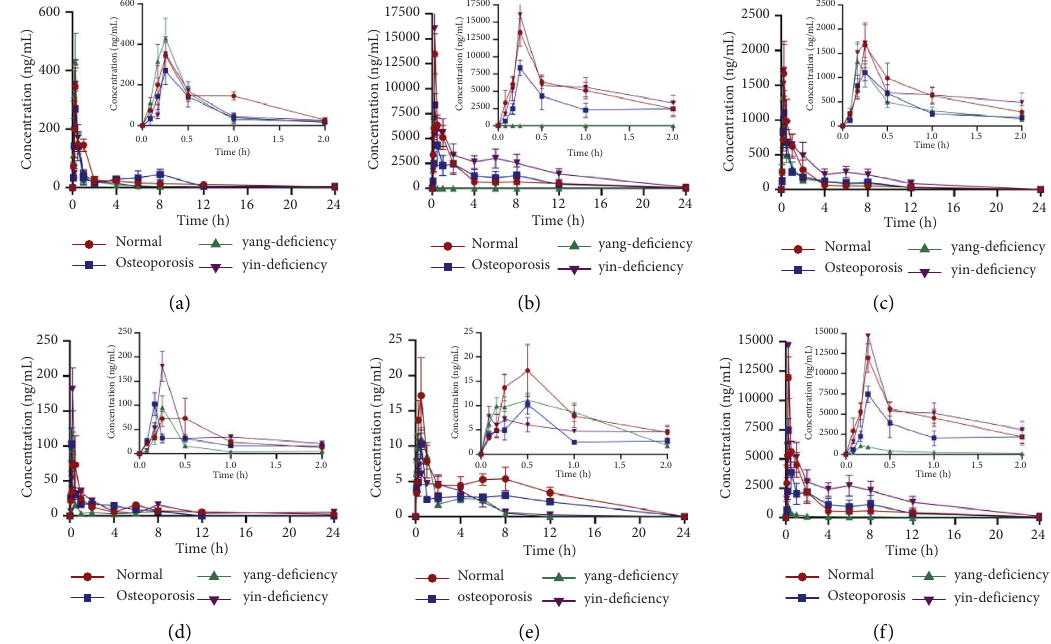
Figure 5: Drug concentration-time profles of chlorogenic acid (a), loganin (b), morroniside (c), aucubin (d), and protocatechuic aldehyde (e) and integrated blood concentration-time comparison chart (f) ( n �